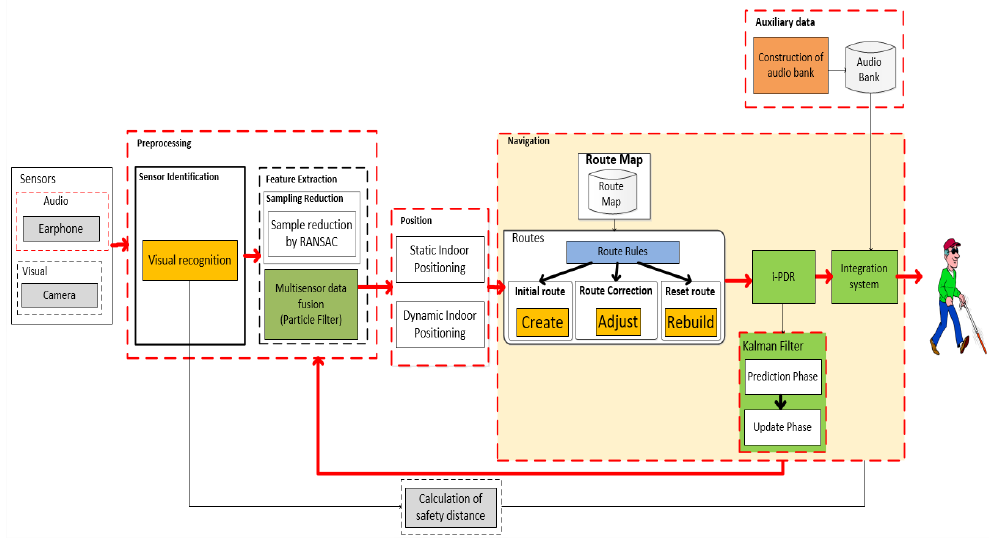
Figure 1. Indoor navigation system architecture. RANSAC, random sample consensus; i-PDR, iterative pedestrian dead